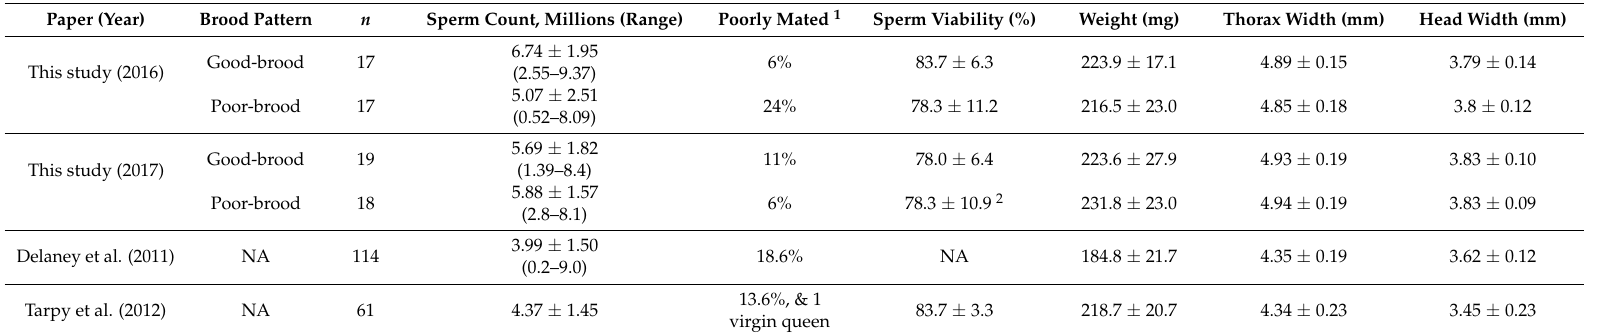
Table 1. The current study’s summary of queen quality results compared to the results from previous studies [6,11], including the number of queens tested ( n ) and the mean ( ± SD) values of morphometric and mating quality measures. Queens from this study are compared between brood pattern groups, with the queens from 2017 classified by their source colony status (before the exchange) of good-brood or